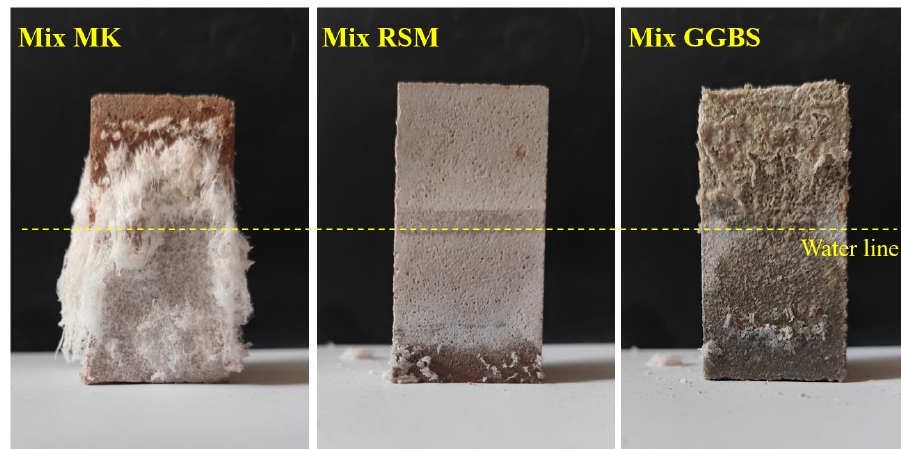
Figure 22. The visual efflorescence extent of